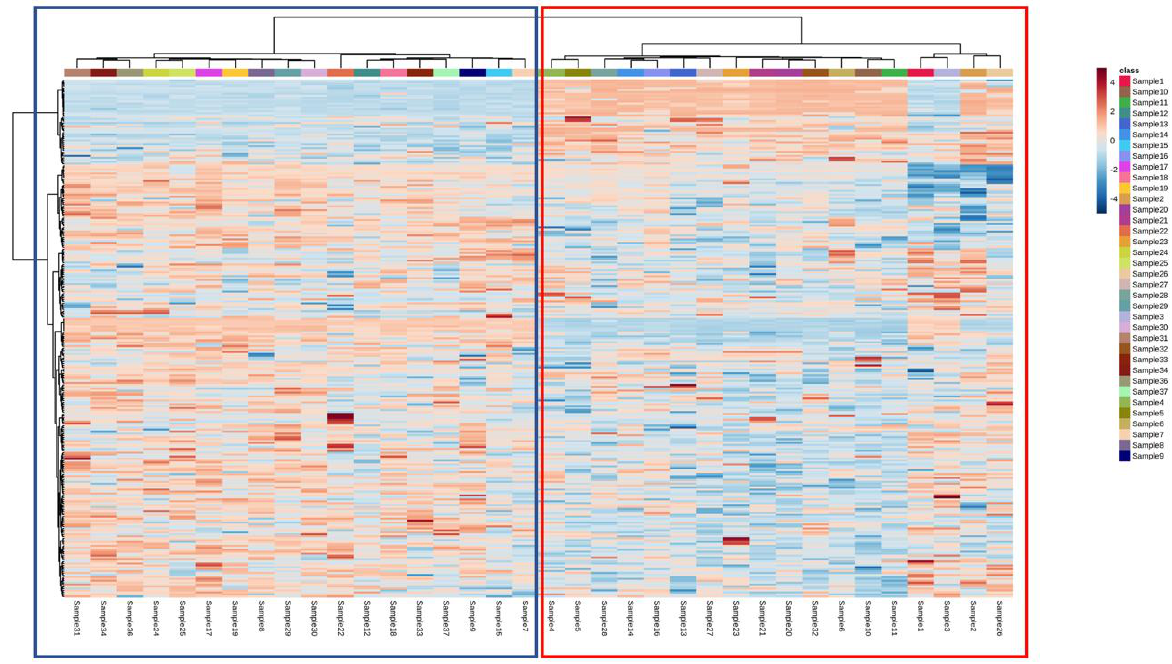
Figure 1. Heat map resulting from the unsupervised hierarchical cluster analysis of the different milk samples under investigation. Two main clusters (i.e., blue on the left and red on the right) could be